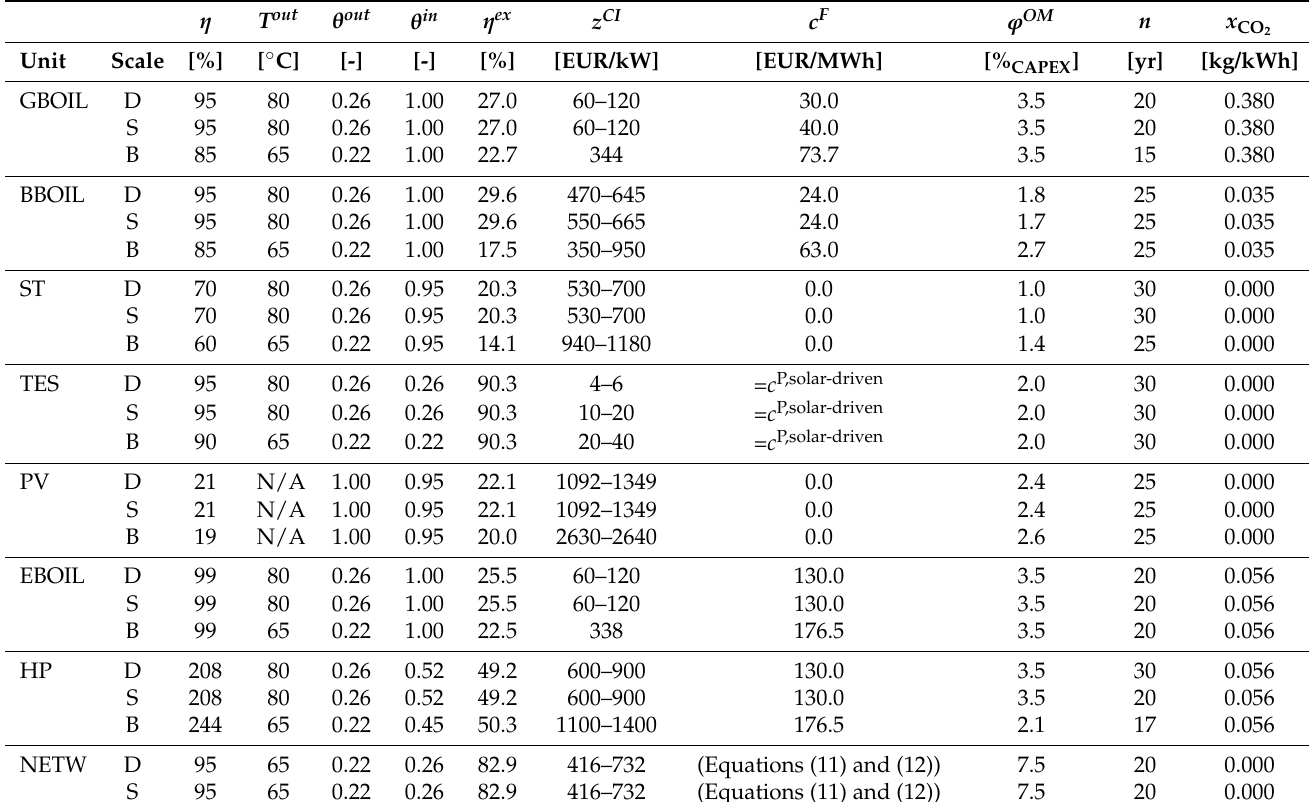
Table 2. Unit-by-unit performance, economic and environmental parameters, at each scale size. Whenever a range of values is shown, the nominal case refers to the arithmetic average. Lower and upper bounds were used for sensitivity